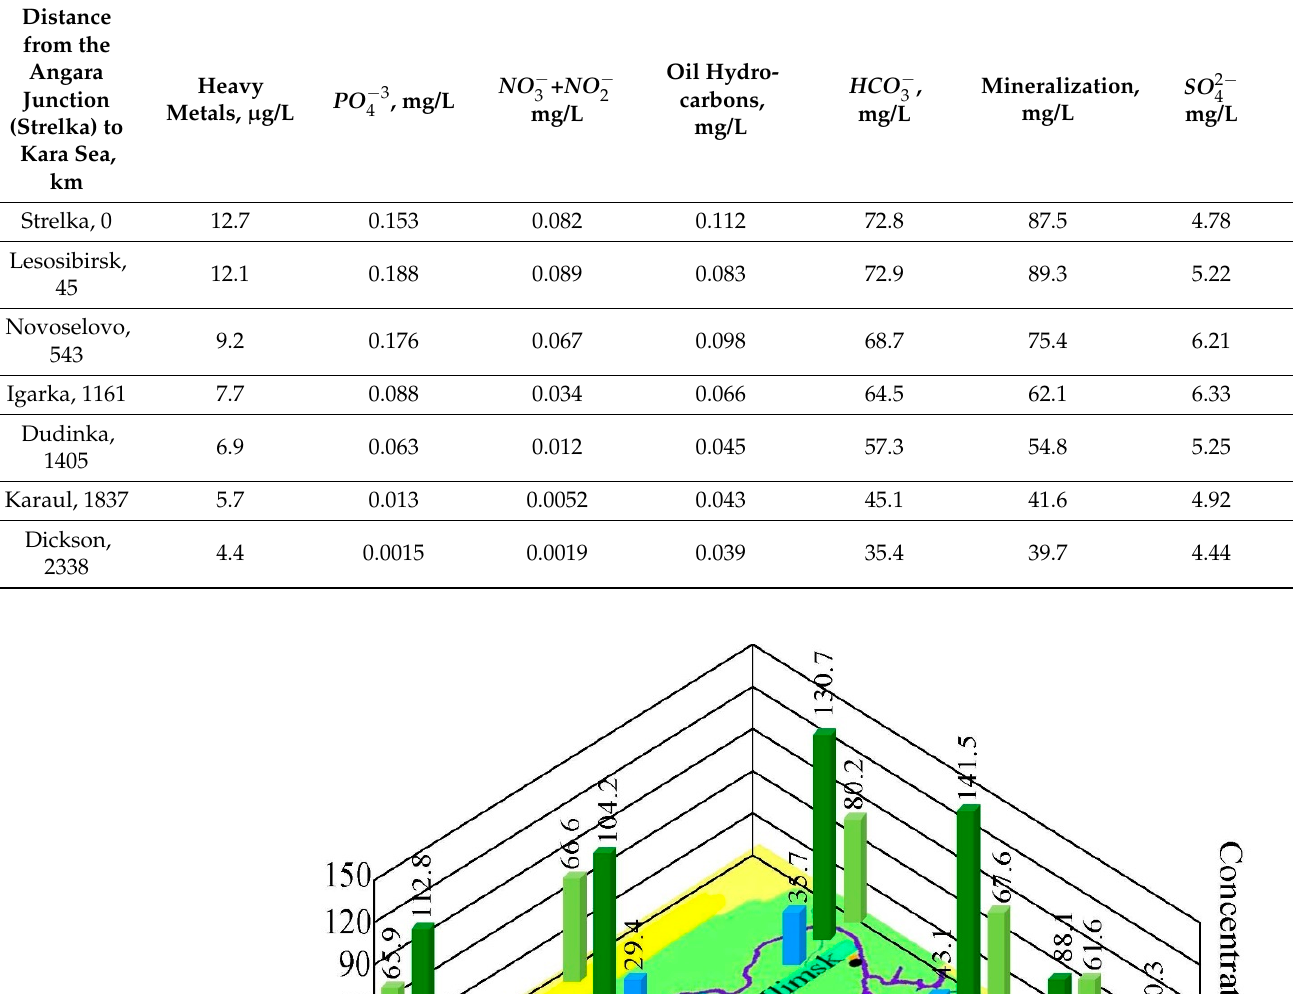
Table 6. Model evaluation of the hydrochemical characteristics of water delivered from the Yenisei River to the Kara Sea. Distance from the